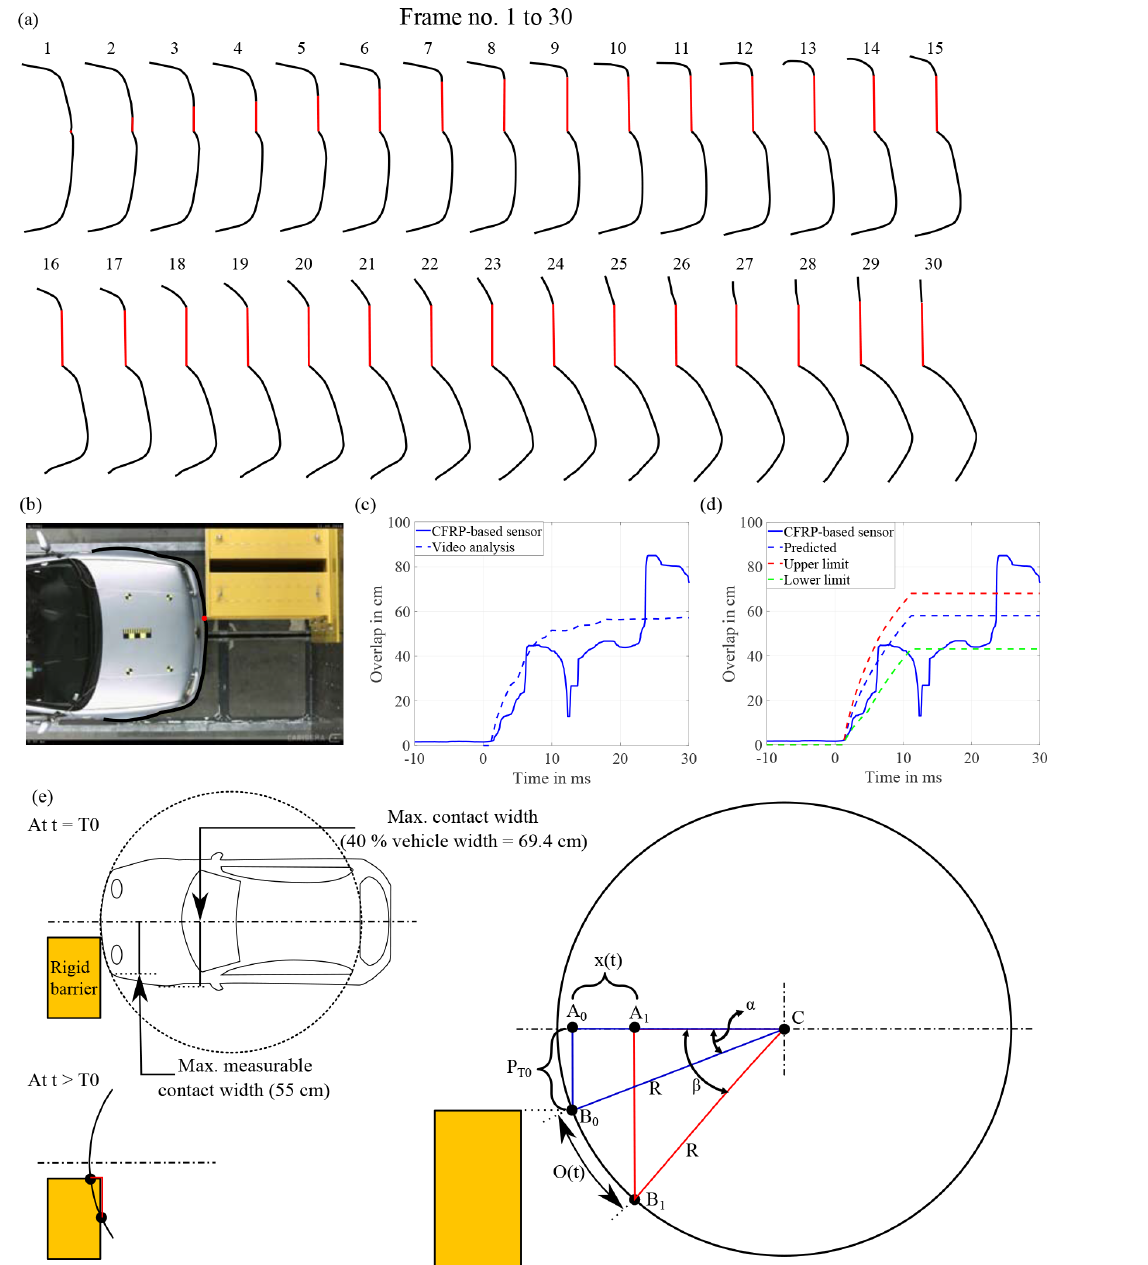
Figure 10. Overlap development: (a) vehicle bumper outline up to 30ms (red line represents overlap), (b) example frame showing the proce- dure for drawing vehicle outline, (c) comparison of overlap development of CFRP-based sensor with video analysis results, (d) comparison of overlap development of CFRP-based sensor with predicted with upper and lower limits, and (e) geometrical schematic for predicting overlap